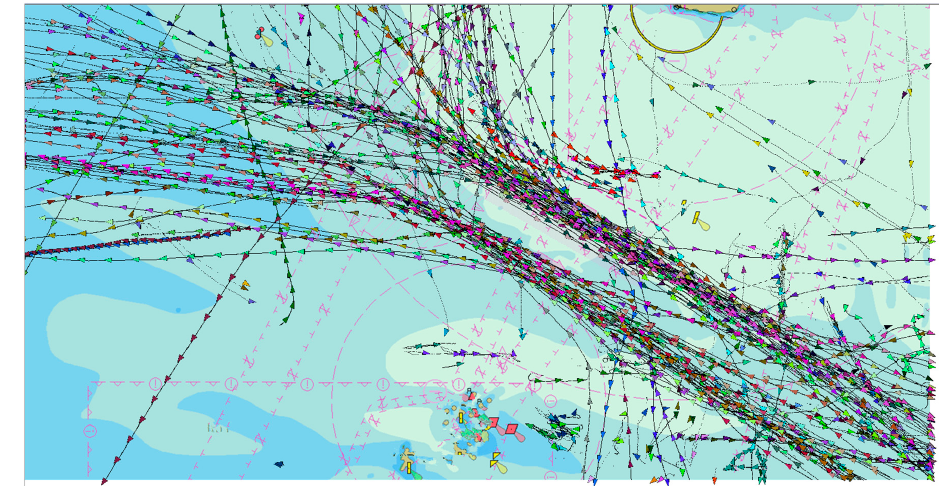
Figure 5. Ship trajectory compression.